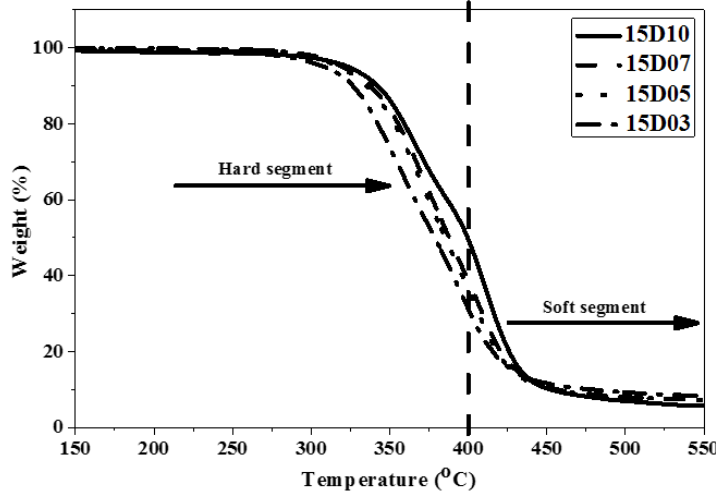
Figure 12. TGA curve of TPU with end-capping agent at concentration of 15 phm.